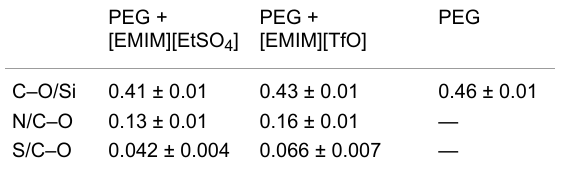
Table 3: XPS atomic ratios for the Si samples coated with PEG, PEG + [EMIM][EtSO 4 ] and PEG +